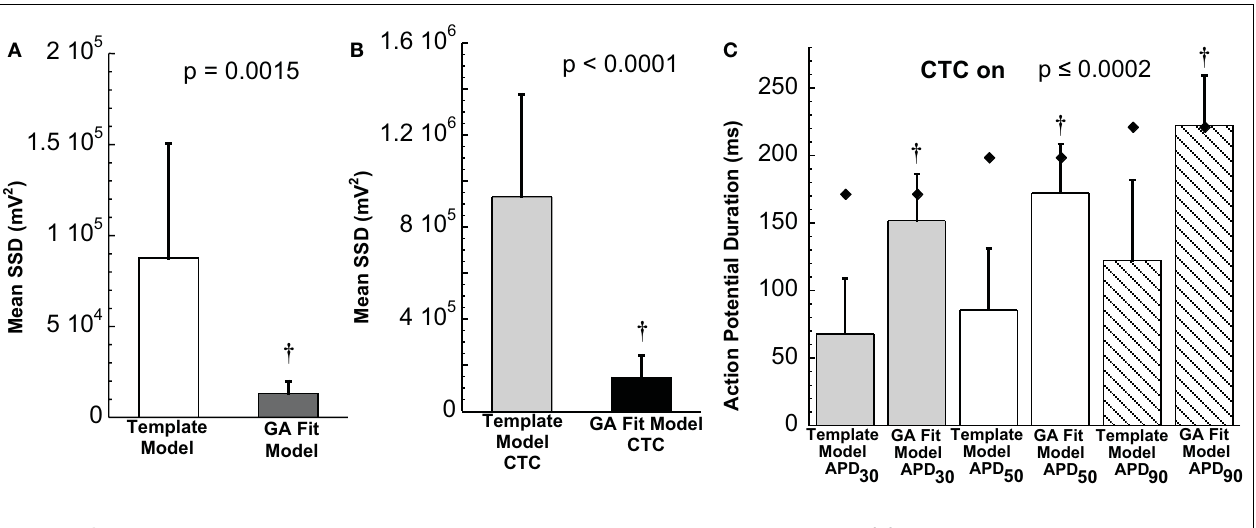
FIGURE 6 | Statistical analysis of target cell matching and CTC performance with guinea pig recipient model. (A) Average error (SSD) between unperturbed in vitro neonatal mouse myocyte APs and either selected template-based model or GA-fit model showing better fits with GA optimization. (B) Average error for CTC-on APs using the guinea pig recipient model demonstrating higher CTC accuracy with GA-optimized models over